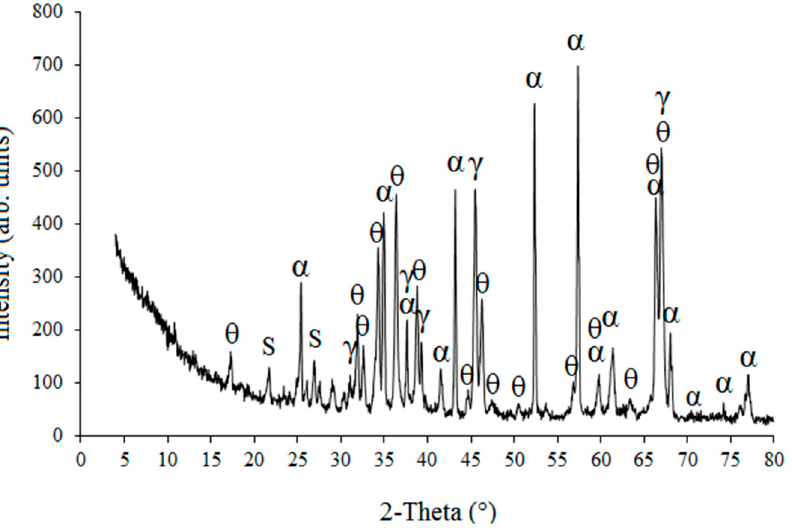
Figure 2. XRD pattern of HCM diffraction curve: α — α‐ Al 2 O 3 ; γ — γ‐ Al 2 O 3 ; θ — θ‐ Al 2 O 3 ; S ‐ SiO 2. The castable mixes were prepared using potable water. Compositions of castables are given in Table